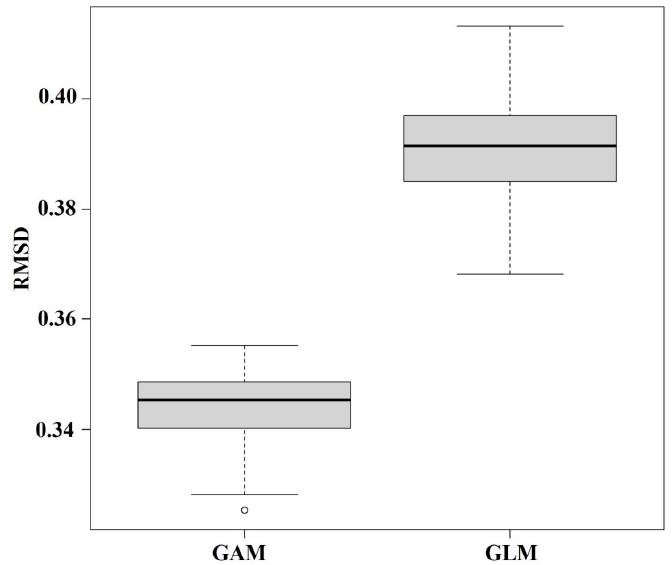
Figure 5. The boxplot graph depicts the GAM and GLM prediction performance based on the root mean square difference (RMSD) value; the model improves if the RMSD value is close to zero.